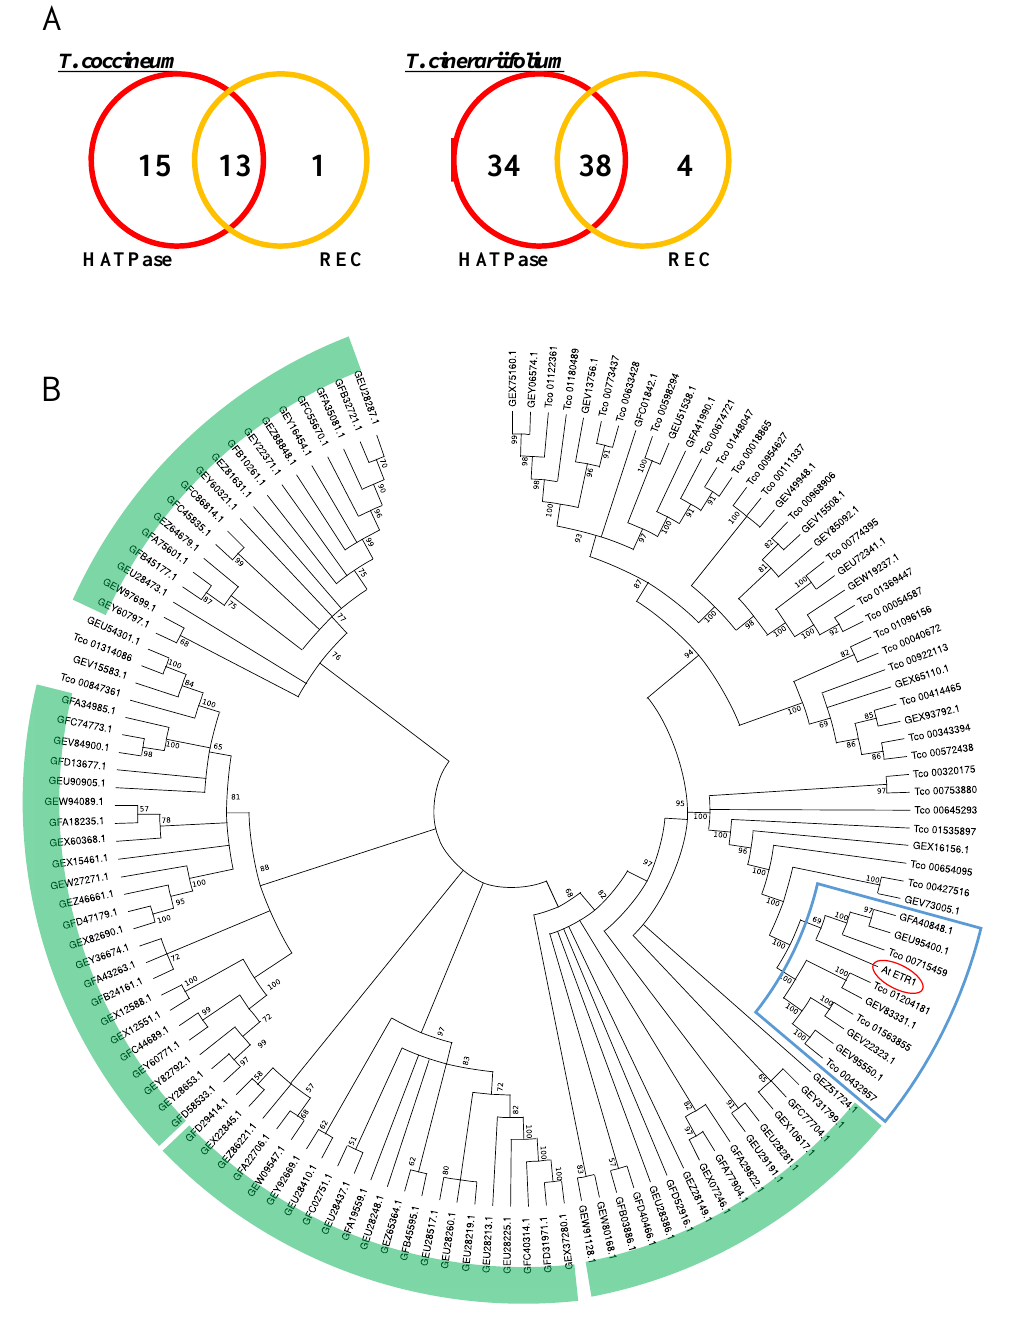
Figure 6. The number of gene-encoding proteins containing histidine kinase domains ( A ), and the phylogenetic analysis ( B ) of histidine kinase superfamily genes. ( A ) Venn diagram of the numbers of T. coccineum and T. cinerariifolium histidine kinase superfamily genes encoding proteins with histidine kinase-like ATPase (HATPase) or phosphoacceptor receiver (REC) domains. ( B ) A phylogenetic tree of the T. coccineum and T. cinerariifolium genes encoding proteins belonging to the signal transduction histidine kinase superfamily. The T. coccineum genes and T. cinerariifolium genes are shown as the name with the prefix “Tco” and the accession No., respectively. The A. thaliana ethylene receptor 1 protein (AtETR1) is circled in red; the AtETR1 cluster that includes five paralogs found in T. cinerariifolium and four paralogs found in T. coccineum is surrounded by a blue line; T. cinerariifolium -specific clusters are indicated by green arcs.